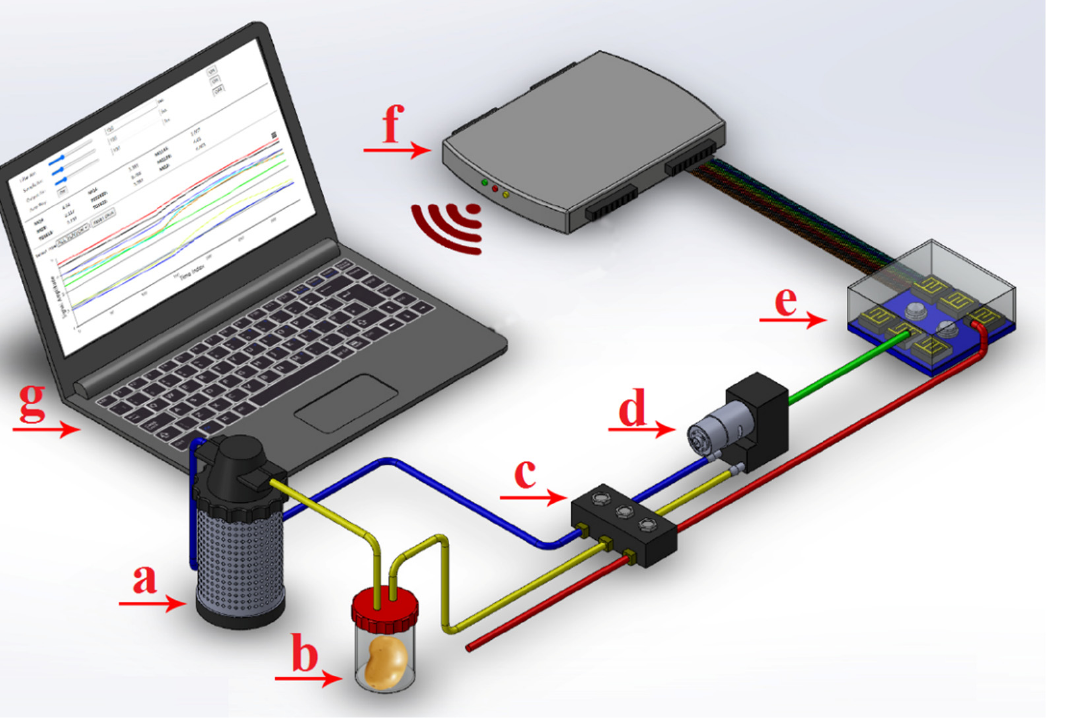
Figure 1. Schematic of an artificial olfactory (e-nose) system. The components of this system consist of the following parts: ( a ) air filter (activated charcoal to remove ambient-air VOC hydrocarbons), ( b ) sample headspace chamber, ( c ) solenoid air valves, ( d ) diaphragm pump, ( e ) e-nose sensor array chamber, ( f ) data acquisition recorder and wireless transmission card, and ( g ) personal computer (PC).